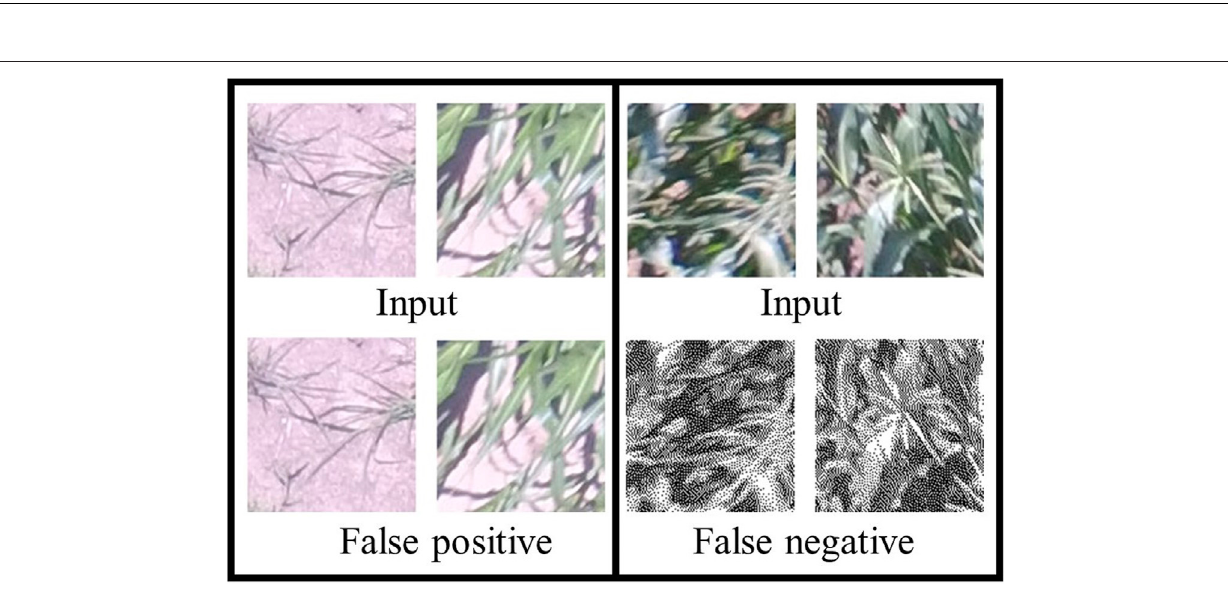
Frontiers in Robotics and AI |